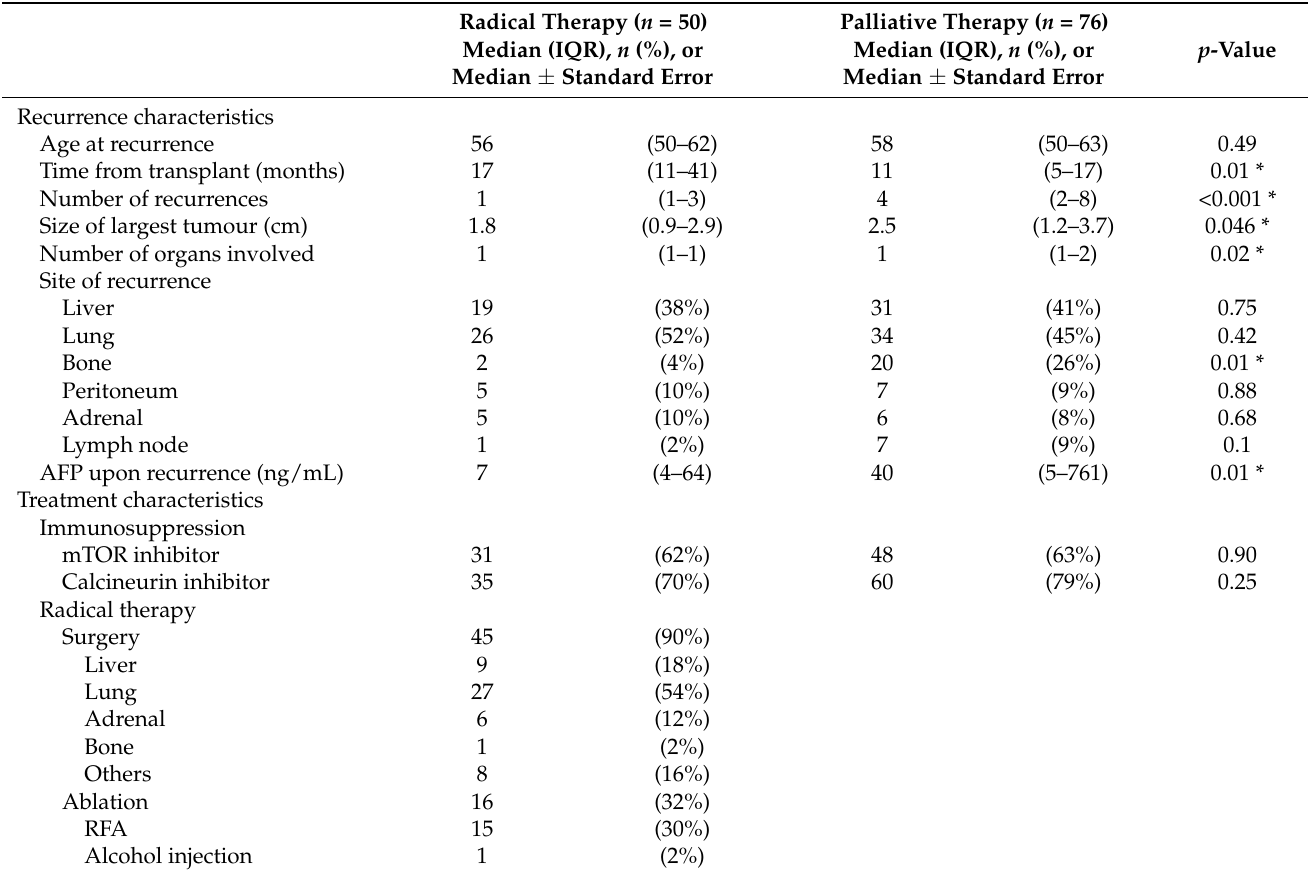
Table 1. Characteristics of patients who underwent radical and palliative